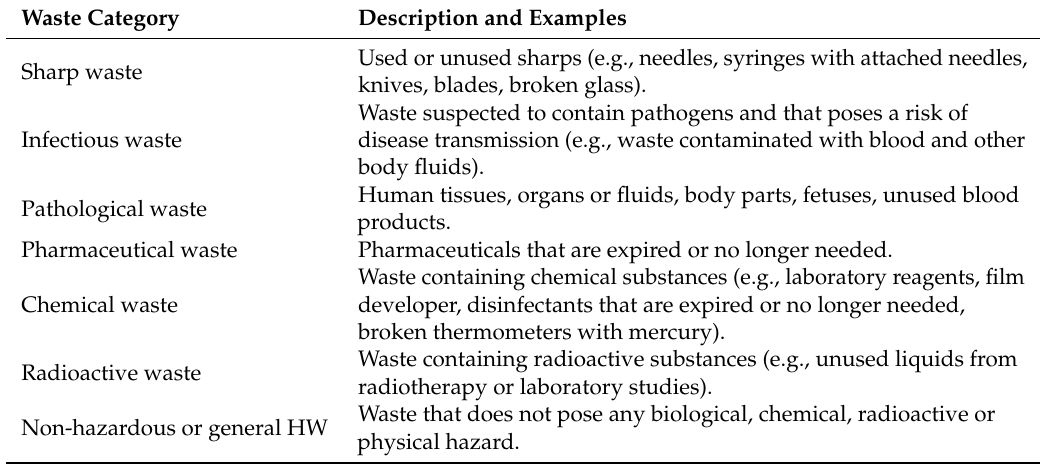
Table 2. Categories of HW as reported by the WHO [79].